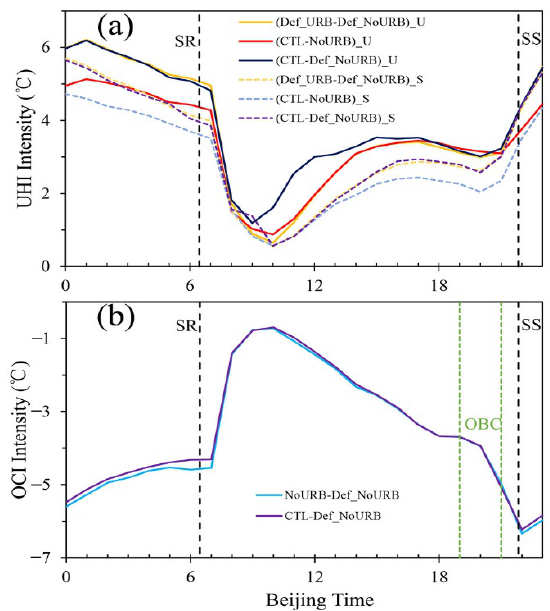
Figure 11. The 4-day average mean of the diurnal evolution of ( a ) the maximum UHI intensity over both Urumqi (_U) and Shihezi (_S) cities extracted from 2 m temperature di ff erences from Def_URB—Def_NoURB, CTL—NoURB and CTL—Def_NoURB. The timing of both sunrise (SR) and sunset (SS) is shown with vertical lines and ( b ) the maximum OCI intensity over the oases’ areas extracted from 2 m temperature di ff erences between NoURB − Def_NoURB and CTL − Def_NoURB. The timing of the OBC event is shown with green vertical lines.